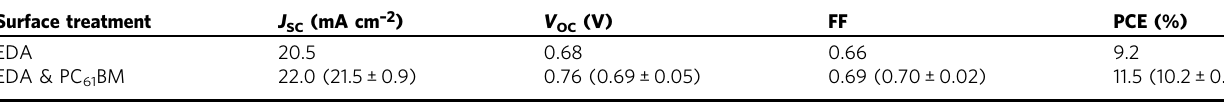
Average values for 30 cells given in